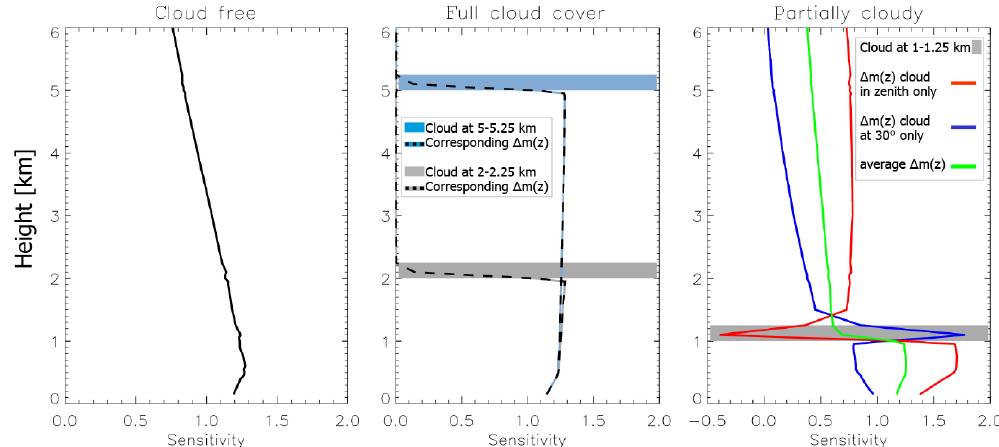
Figure 3. The vertical sensitivity to NO 2 , or height-dependent differential air mass factors, for cloud free conditions (left panel), a homo- geneous cloud cover with a cloud at 2–2.25 or 5–5.25km altitude (middle panel), and partially cloudy conditions with a cloud at 1–1.25km altitude (right panel). For partially cloudy conditions, the cloud can be in the zenith (red), or at 30 ◦ elevation (blue). The green line illustrates the time averaged sensitivity when fields of broken clouds pass over the measurement site. Notice the agreement between this line, below the cloud bottom height ( < 1km), and the sensitivity in the same vertical domain for full cloud cover (middle panel).